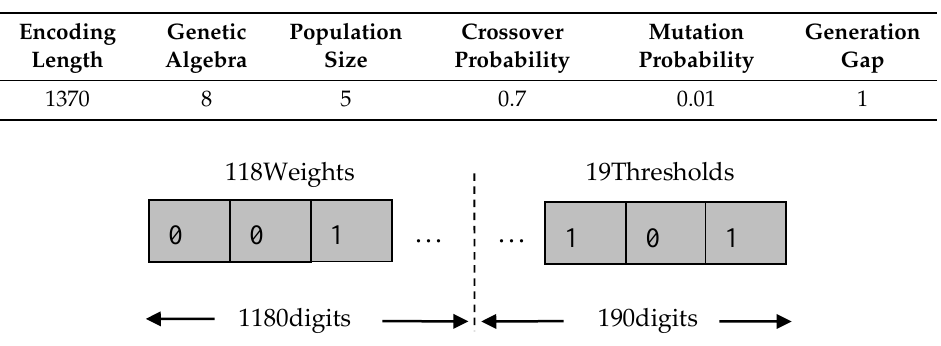
Table 3. The parameters of GA.